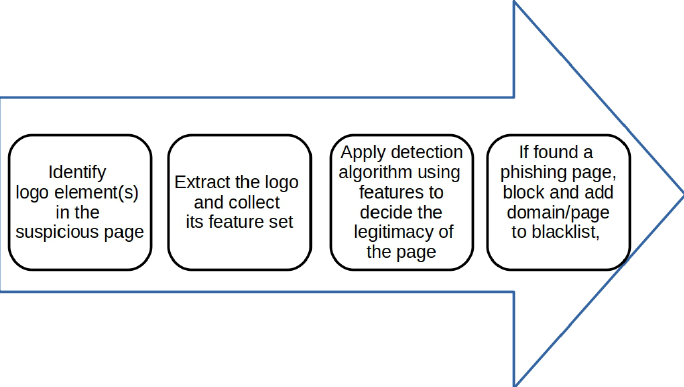
Figure 3. Basic-logo-based phishing web-page